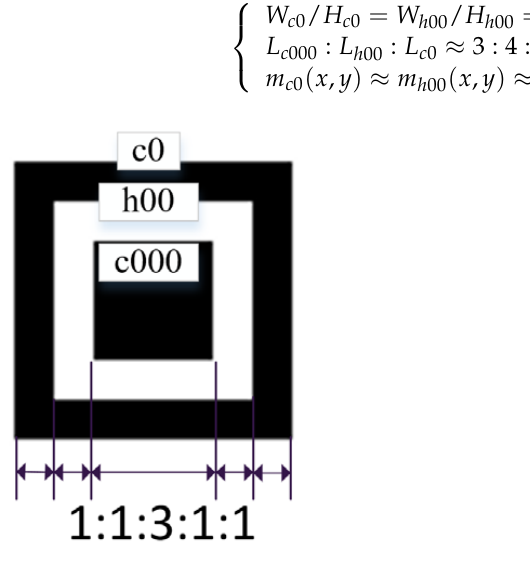
Figure 2. Position detection pattern. As shown in Equation (1), W and H represent the length and width of the contour’s minimum external rectangle, L represents the contour’s length, and m represents the con- tour’s center.